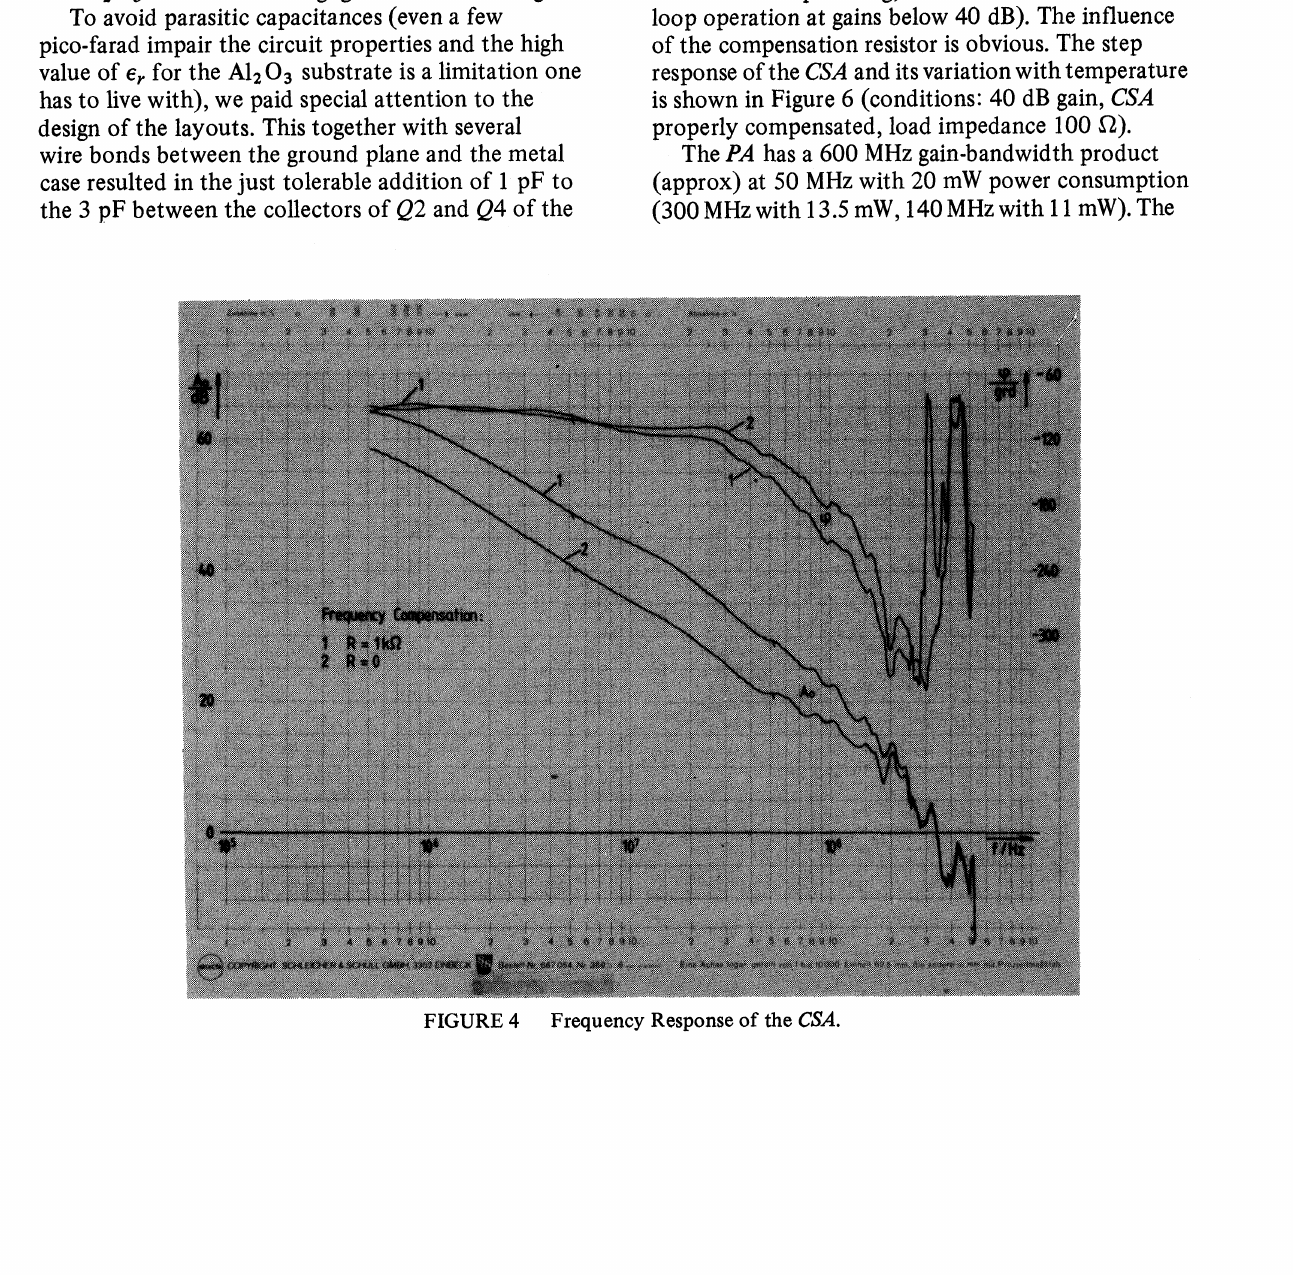
FIGURE 4 Frequency Response of the